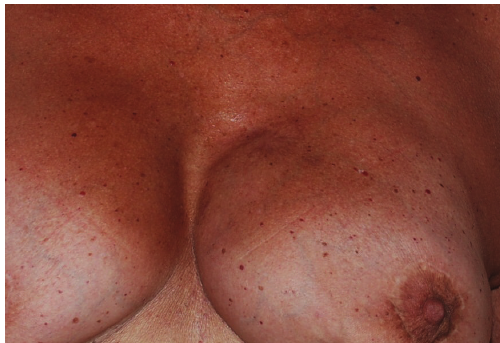
Figure 5: Breast fistula 1-year after fat graft